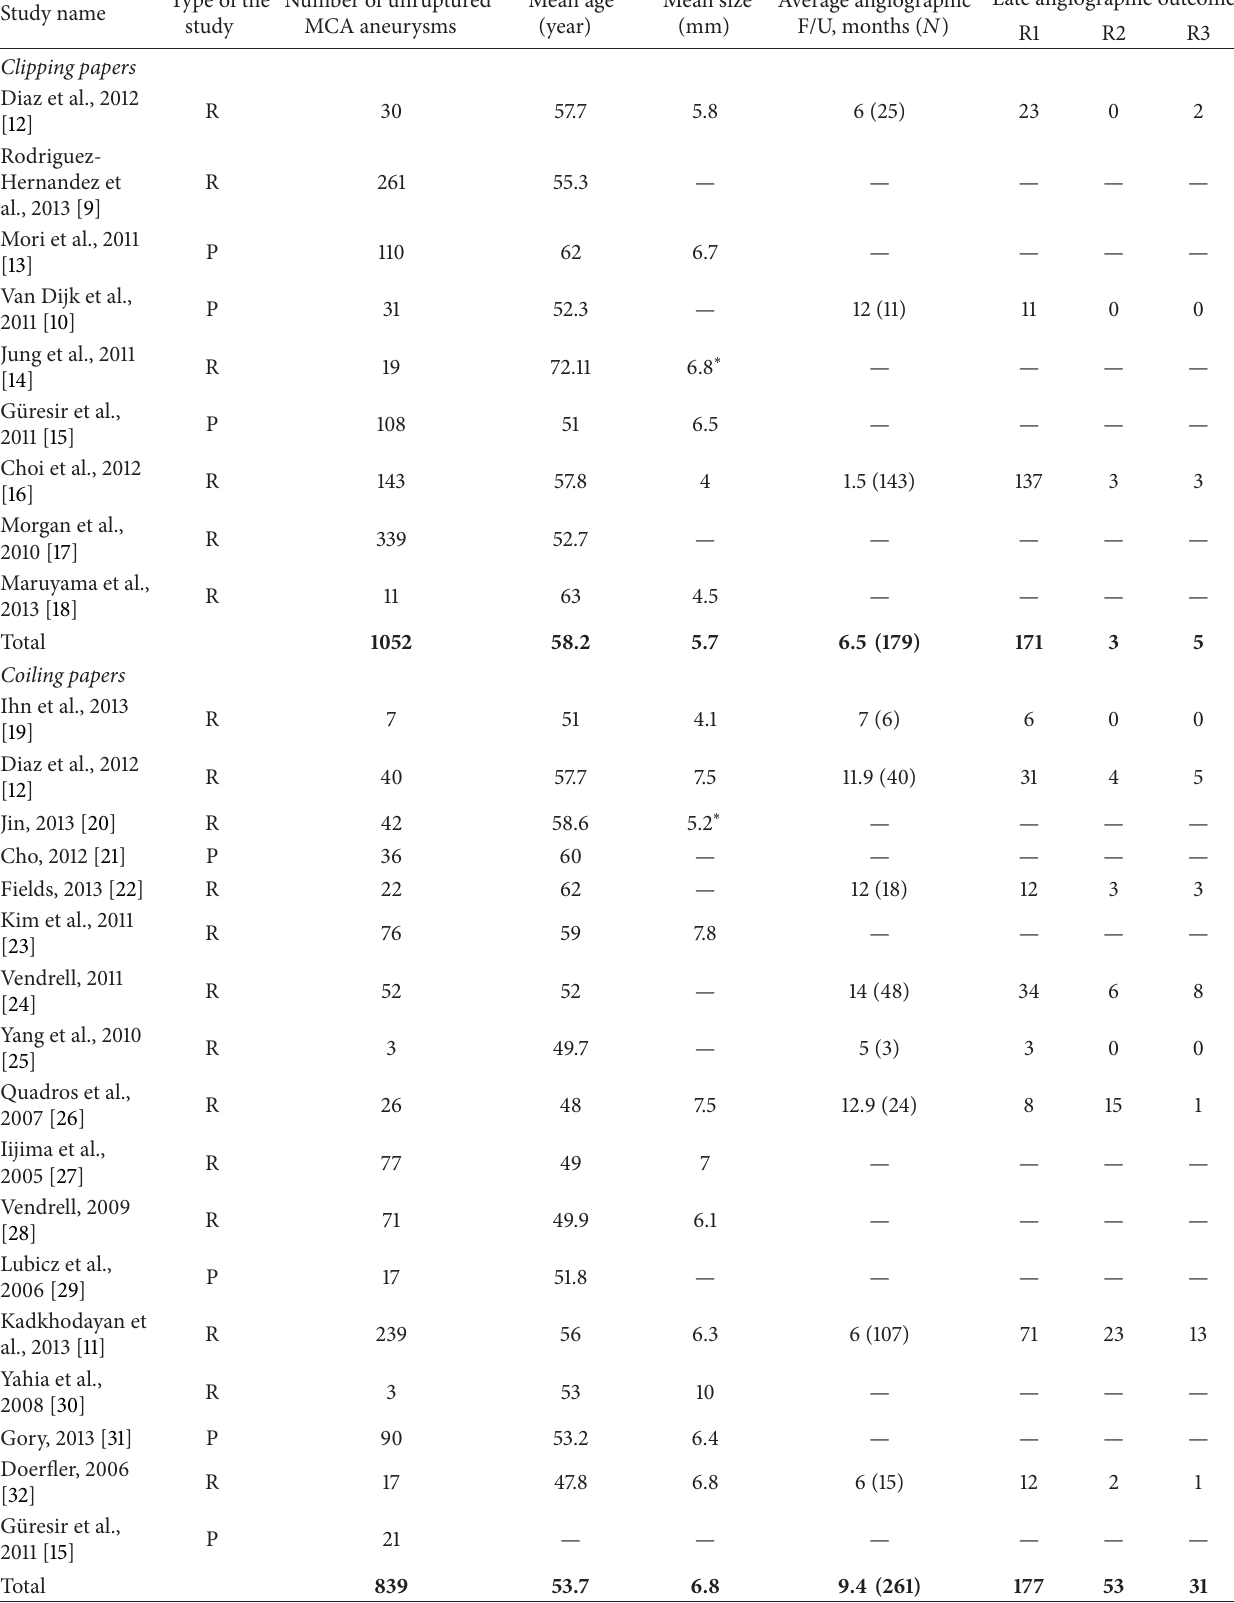
Table 1: Demographic and angiographic results of clipping and coiling